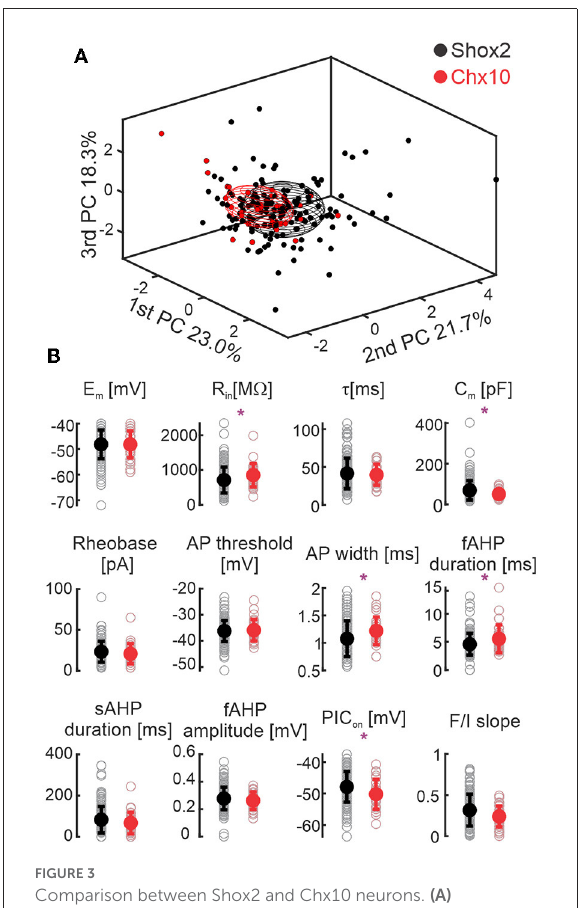
FIGURE3 Comparison between Shox2 and Chx10 neurons. (A) Three-dimensional representation of 143 Shox2 neurons (black dots) and 28 Chx10 neurons (red dots) on the three principal components (same as Figure 2, but different angle). Ellipsoids are centered on the mean for the three first PCs and semi-axes are generated by the standard deviation of each of the three first PCs. Black and red ellipsoids represent groups of Shox2 and Chx10 neurons, respectively. (B) Comparison of electrophysiological properties measured from Shox2 neurons (black) and Chx10 neurons (red). Filled circles represent the mean and error bars the standard deviation, unfilled gray circles represent individual neurons. Resting membrane potential (E m ), input resistance (R in ), time constant ( τ ), calculated capacitance (C m ), rheobase, action potential (AP) threshold, AP width, fast after hyperpolarization (fAHP) duration, slow afterhyperpolarization (sAHP) duration, fast after hyperpolarization (fAHP) amplitude, PIC activation voltage (PIC on ), and slope of the AP frequency/current (F/I) curve. * p < 0.05, unpaired t -test or Mann-Whitney